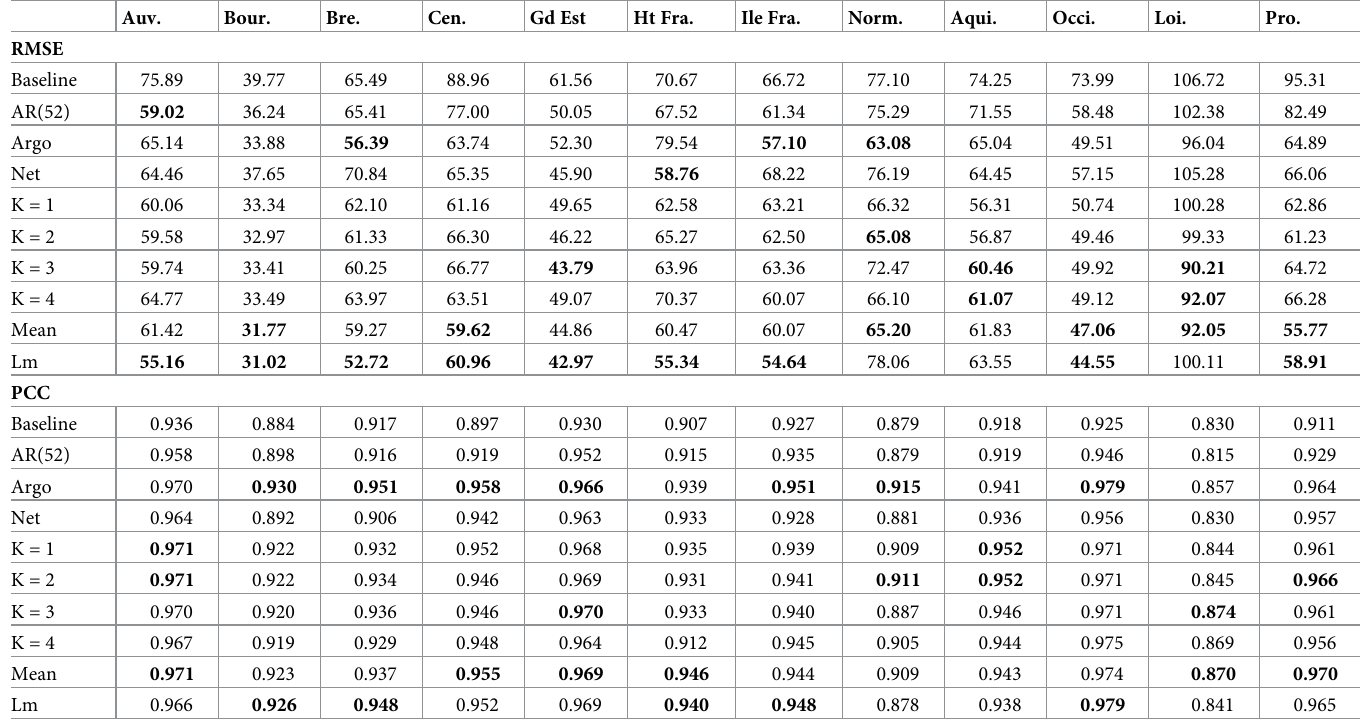
Table 10. PCC and RMSE for real-time estimate for all french regions for the period starting from January 2015 to March 2017. Auv. Bour.